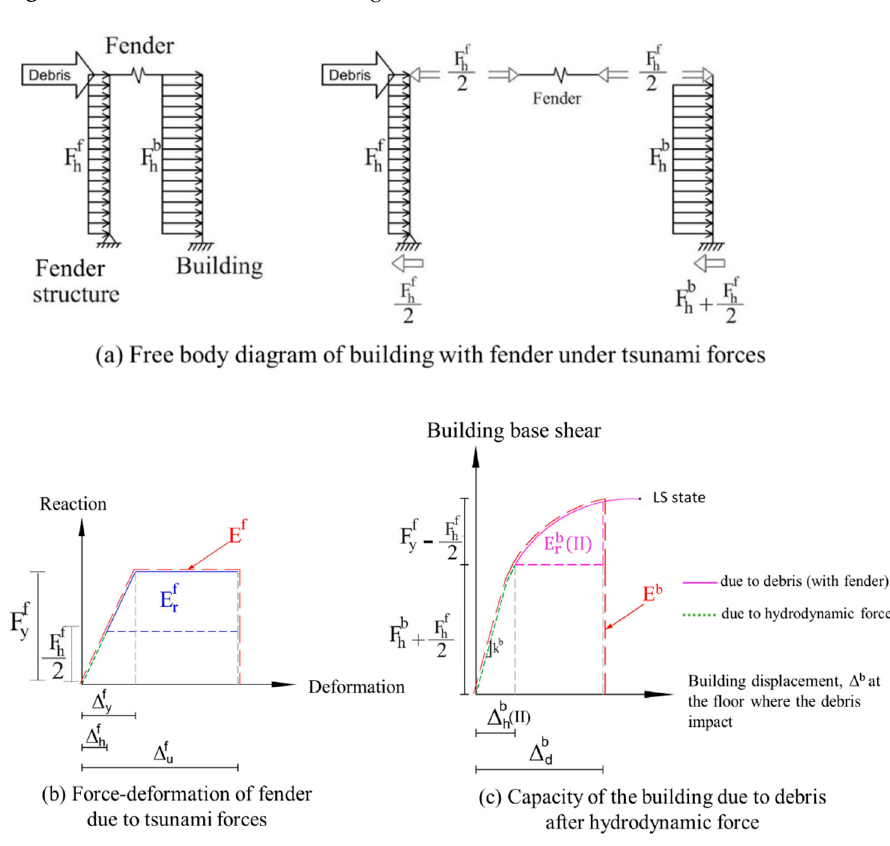
Figure 22. Idealization of the building with a fender structure.